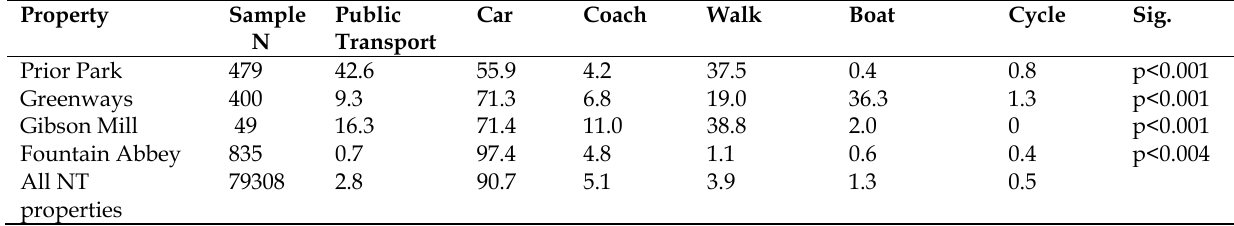
Table 10. Mode of Transport Used to Access NT Properties adopting Specific Measures